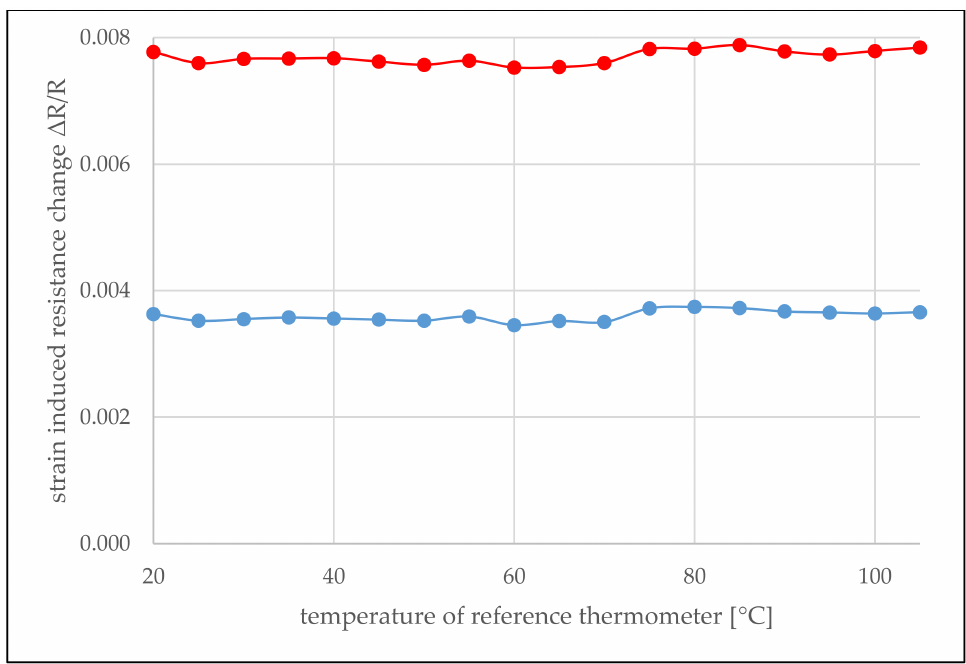
Figure 7. Strain-induced ∆ R / R in dependence of temperature for the SFC sensor (in blue) and the stain gauge sensor (in